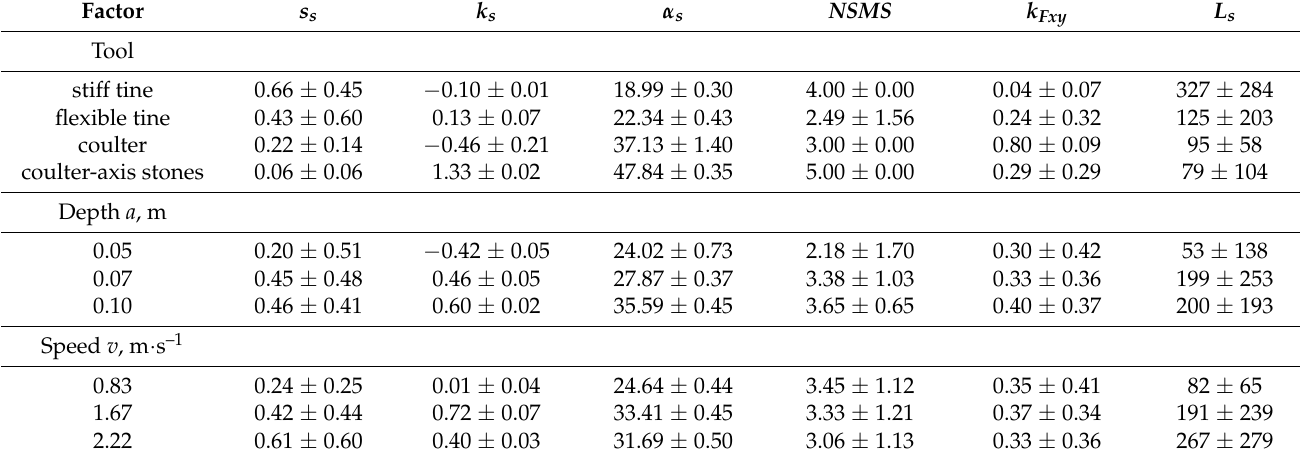
Table 7. Mean values and standard deviations of parameters characterizing the movement of stones embedded in the soil under the influence of contact with working elements operating at different depths and speeds.